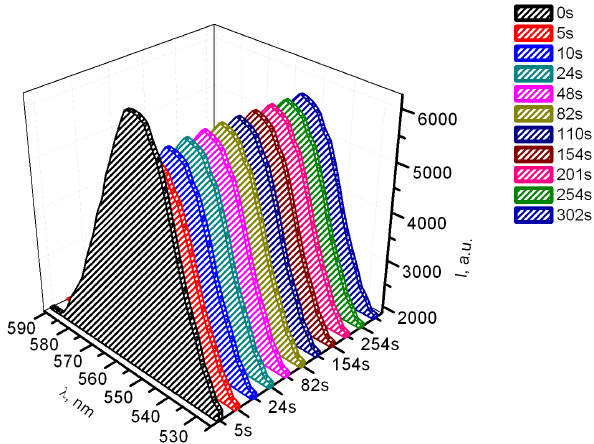
Fig. 3. Dynamics of °uorescence spectra change of bengal rose. Wavelength of excitation is 515 nm. Spectrum was cal- culate for condition C cell ð x ; 0 Þ ¼ 0 : 4.